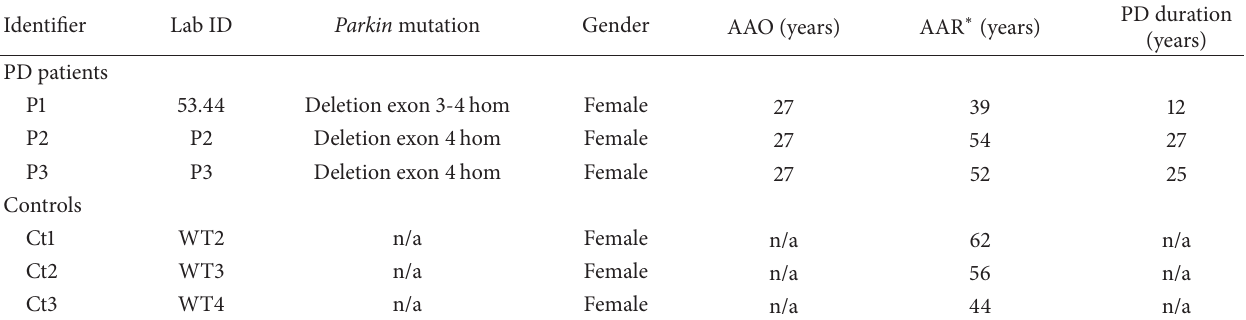
Table 1: Genotypic and demographic characteristics of the six dermal fibroblast donors used in this